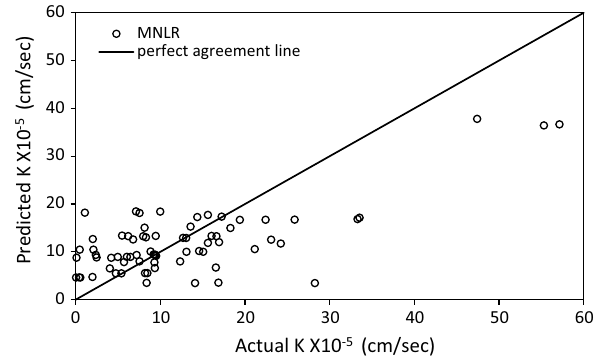
Fig. 4 Actual versus predicted values of hydraulic conductivity using MNLR model (testing data) Table 4 Statistical performance measures for modelling approaches